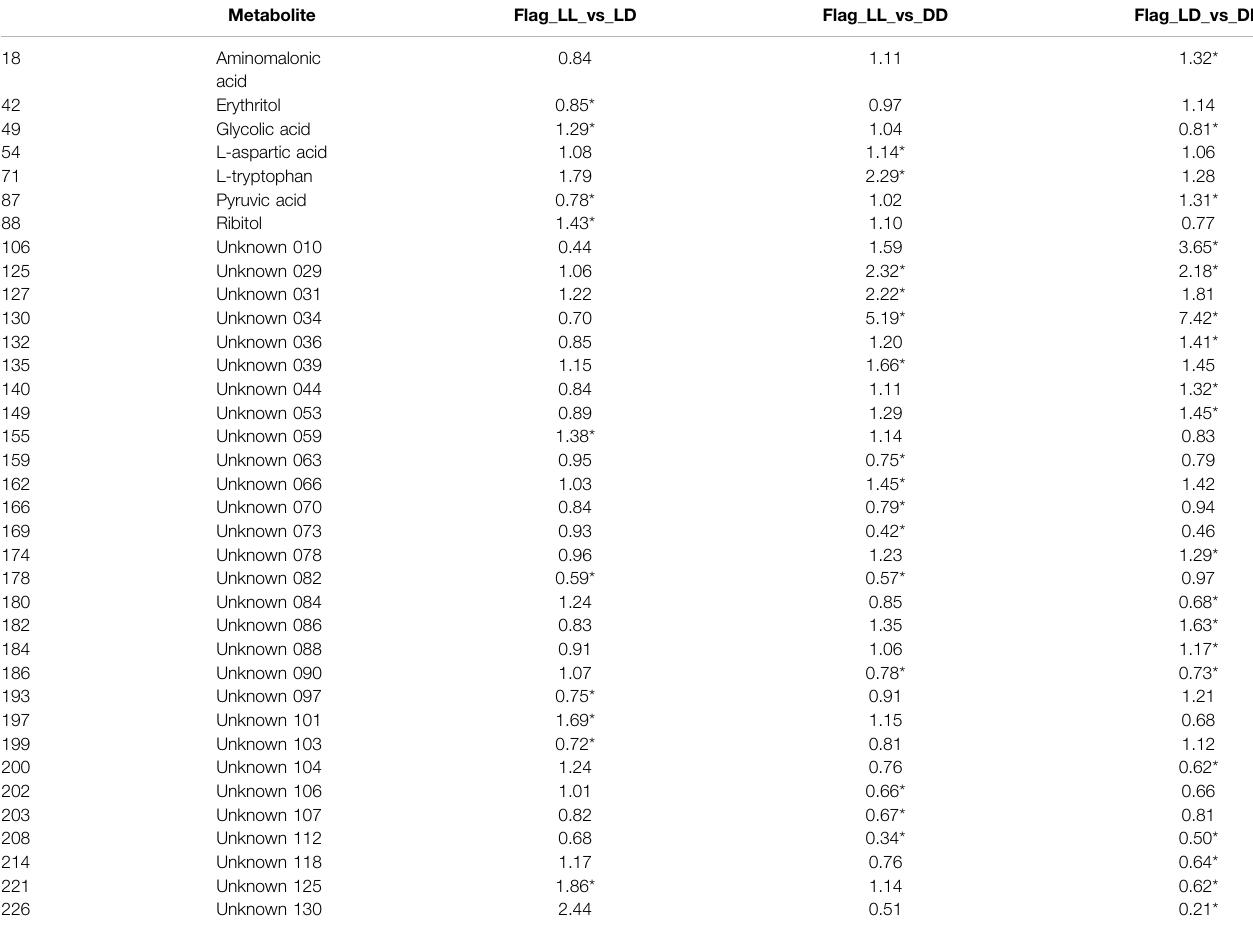
The value indicates the fold-change. *p <